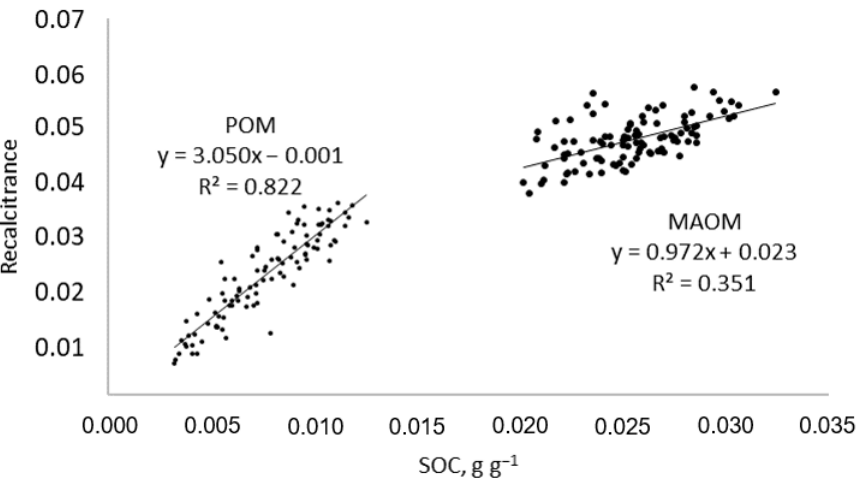
Figure 6. Relationships between soil organic carbon (SOC) and recalcitrance of particulate organic matter (POM) and mineral-associated organic matter (MAOM).